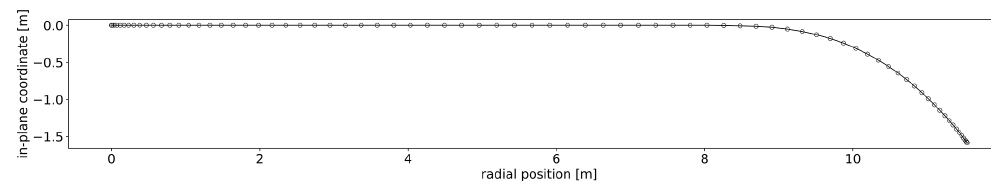
Figure 10. Distribution of aerodynamic sections along the